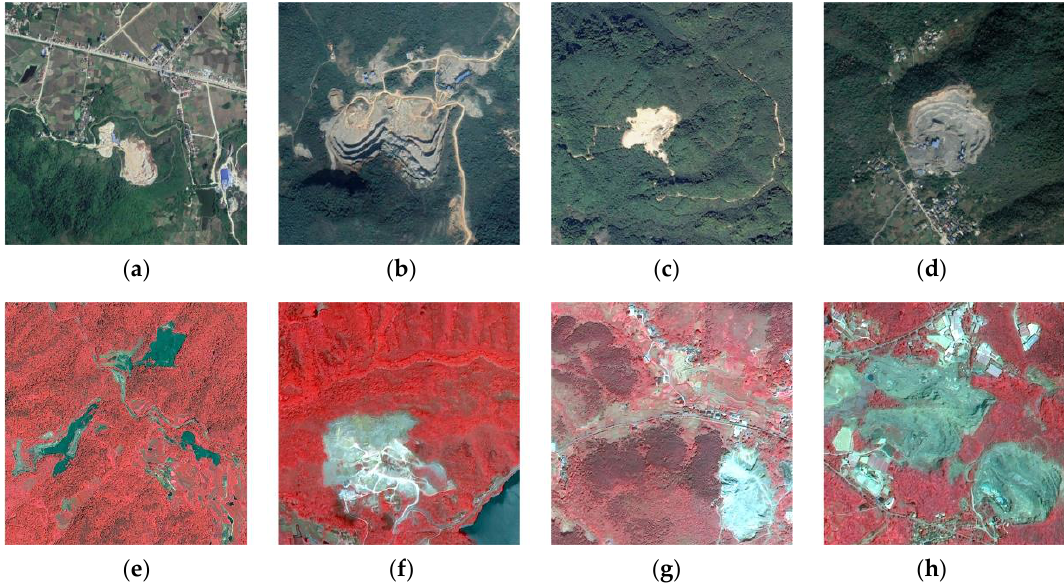
Figure 6. Identification index. True-color images: ( a ) iron mine in Qichun County; ( b ) quarry mine in Yangxin County; ( c ) granite mine in Xingshan County; ( d ) coal mine in Huangshi City; false-color images: ( e ) coal mine in Yuan`an County; ( f ) quarry mine in Chibi City; ( g ) quarry mine in Chongyang County; ( h ) coal mine in Daye City.